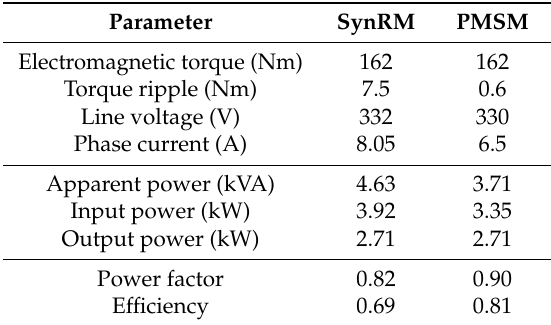
Table 8. SynRM and PMSM characteristics for the same torque